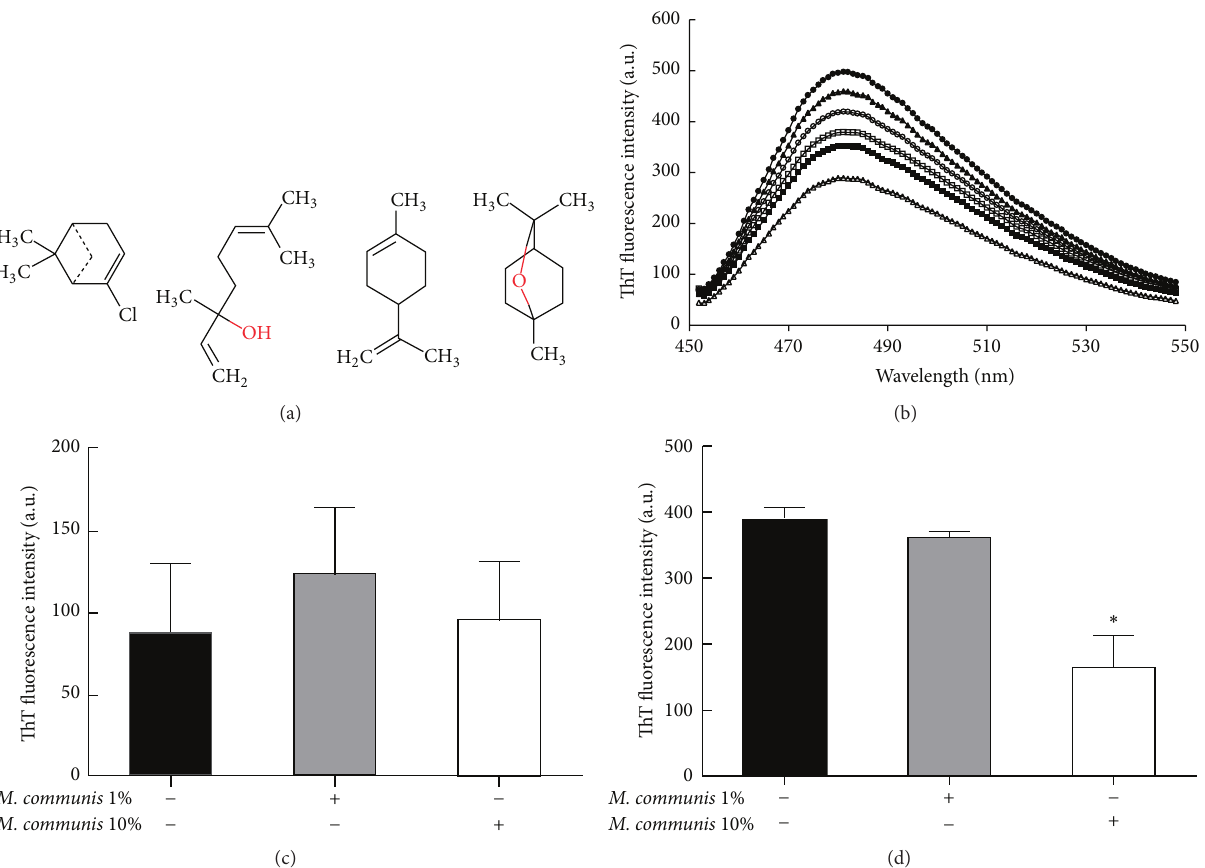
Figure 5: (a) Chemical structures of 𝛼 -pinene, limonene, 1,8-cineole, and linalool (left to right, resp.). (b) The 𝛼 -Syn fibrillation rate in the absence ( e ) and presence of 2% (v/v) of 𝛼 -pinene ( ◼ ), limonene ( 󳵻 ), 1,8-cineole ( 󳵳 ), linalool ( I ), and the heated oil ( ◻ ). (c) The fibrillation rate of 2mg/mL of insulin and (d) HEWL in the absence (black) and the presence of 1% (gray) and 10% (white) (v/v) of M. communis . The proteins were diluted in glycine buffer (30 mM; pH 2.5) and treated with the oil and then incubated for 24 hours at 57 ∘ C. The fibrillation rate was measured by ThT fluorescence assay. The chemical structures were drawn by Marvin-Sketch software. ∗ 𝑃 < 0.05 (one-way ANOVA) indicated the samples are significantly different from the